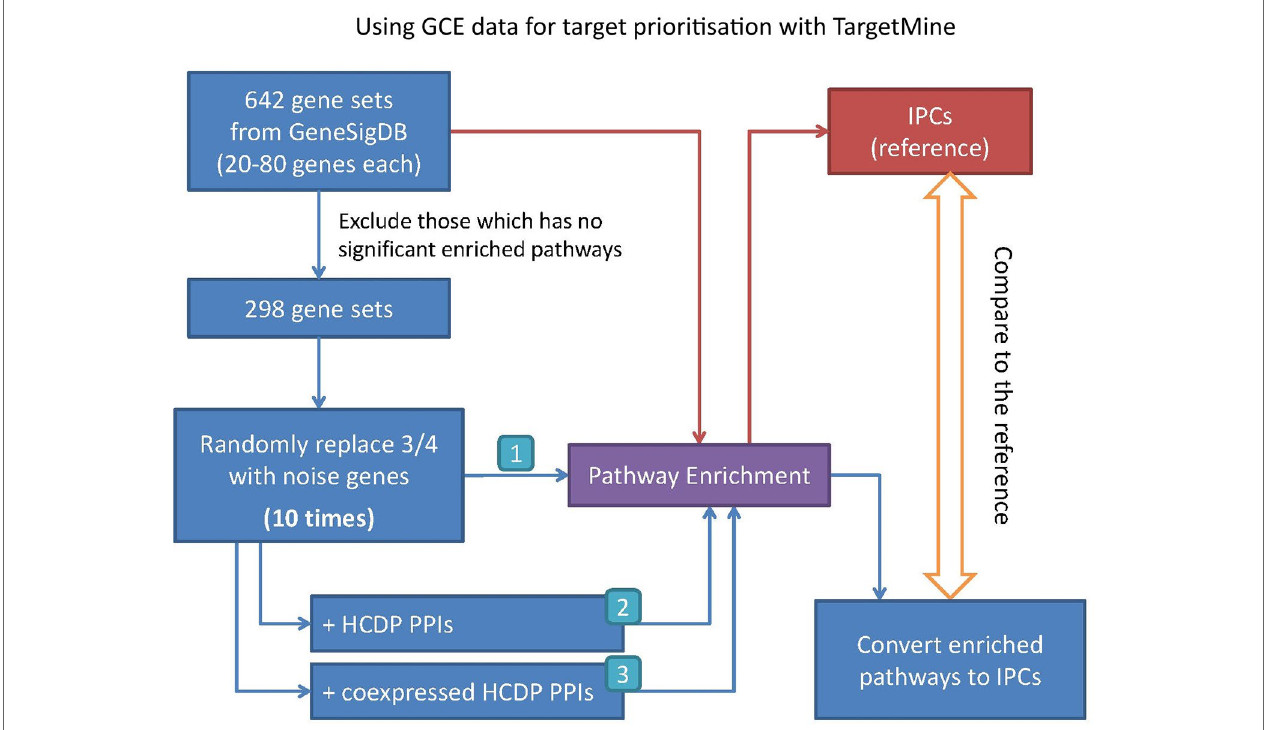
FIGURE 1 | Assessing the potential benefits of including GCE data in target prioritisation with TargetMine. GCE, gene co-expression; HCDP, high-quality direct physical PPIs; IPC, integrated pathway clusters; PPI, protein–protein interactions.